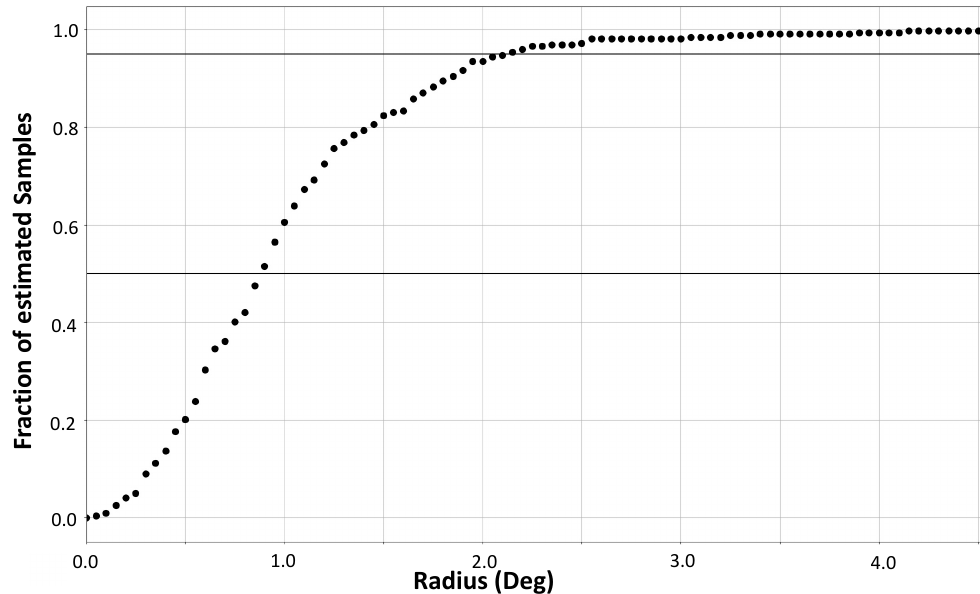
Figure 10. Sensitivity for gaze resolution: fraction of gaze estimates falling within a given radius of corresponding ground truth gaze values.